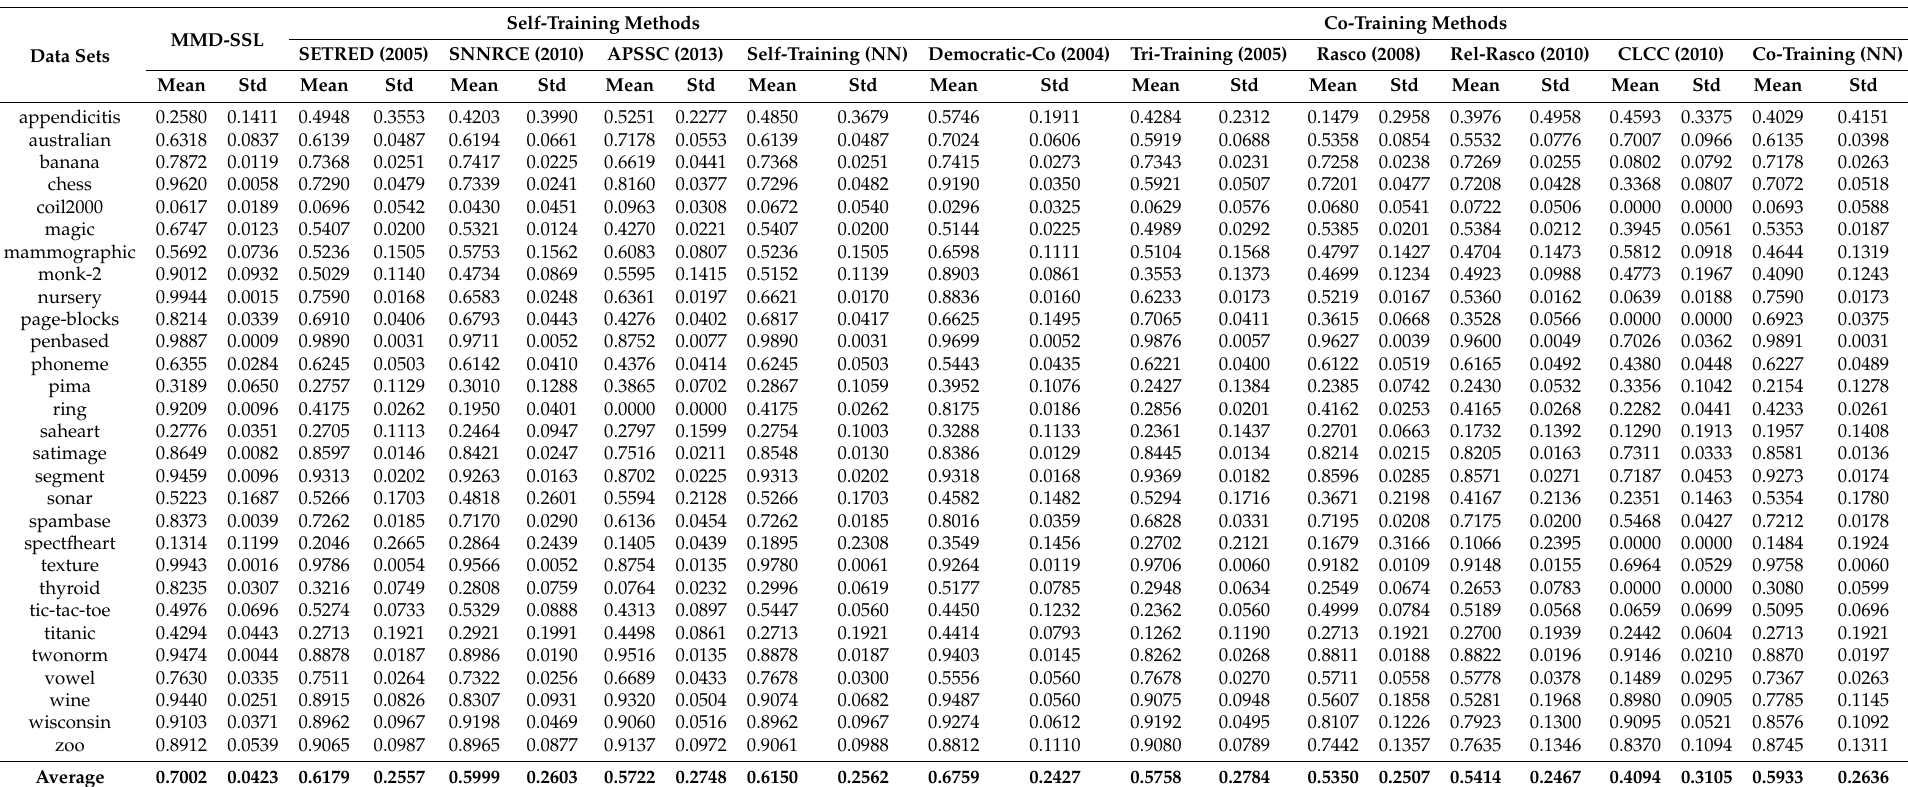
Table 6. Kappa comparison of MMD-SSL algorithm and 10 other SSL algorithms on 30% labeled data.